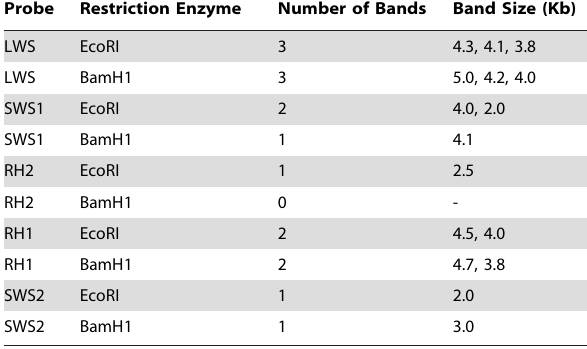
Table 2. Southern blot results.